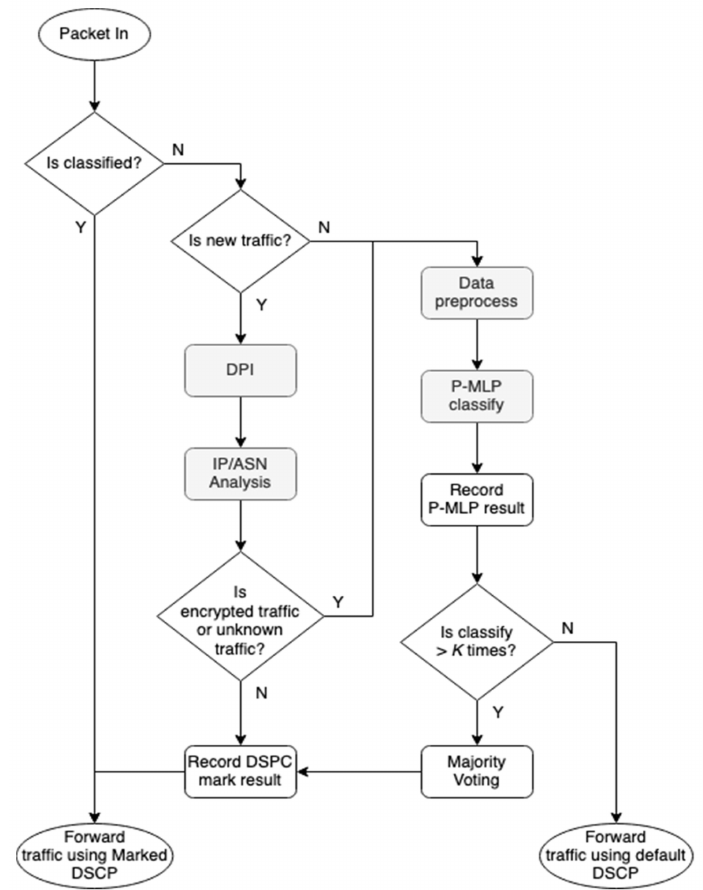
Figure 12. Hybrid traffic classification